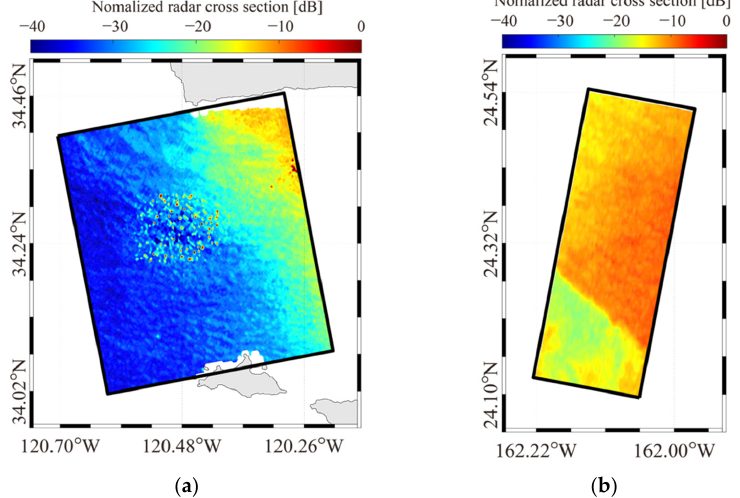
Figure 10. The composited NRCS map, including the Bragg resonant and N-P contribution: ( a ) GF-3 image acquired at 01:58 UTC on 5 May 2017; ( b ) TS-X image acquired at 16:53 UTC on 3 August 2009. The composited NRCSs were compared with the observations of the GF-3 and TS-X